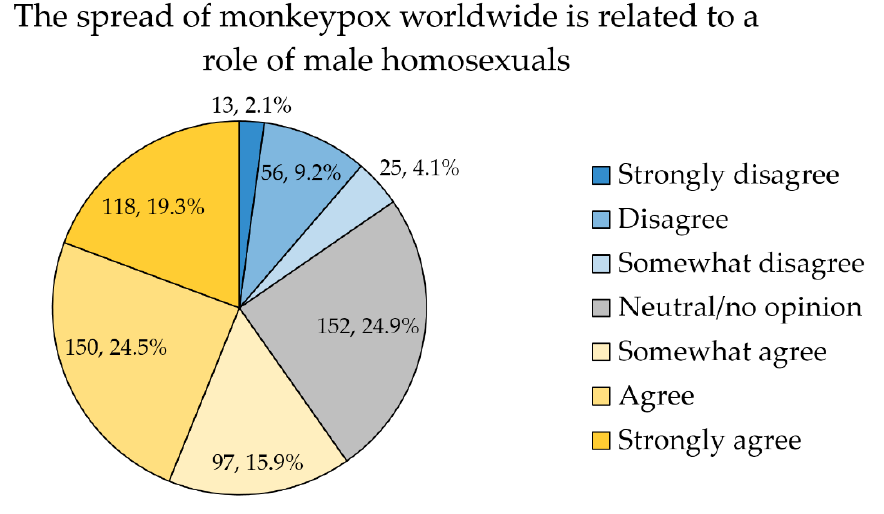
Figure 3. The attitude of the study participants towards the role of male homosexuals in monkeypox spread. participants in the agreement category had a higher MPX K-score (mean = 3.2 vs. 2.6